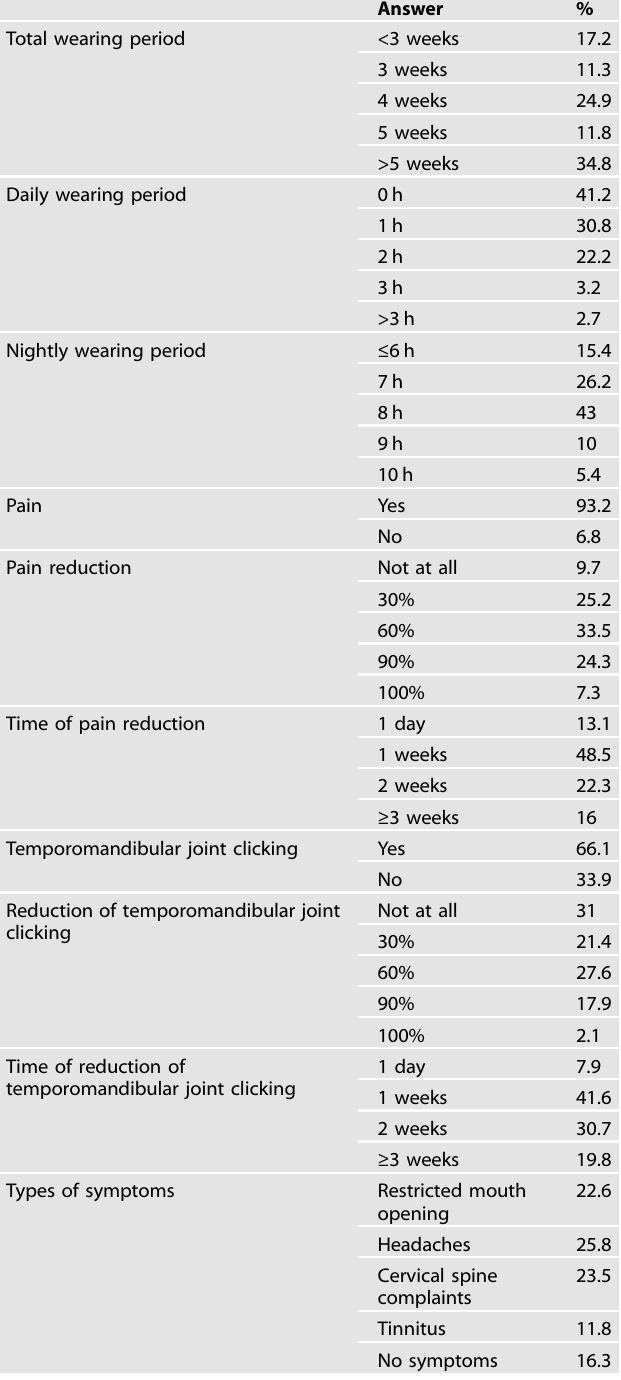
Table 1. Results of the analyzed